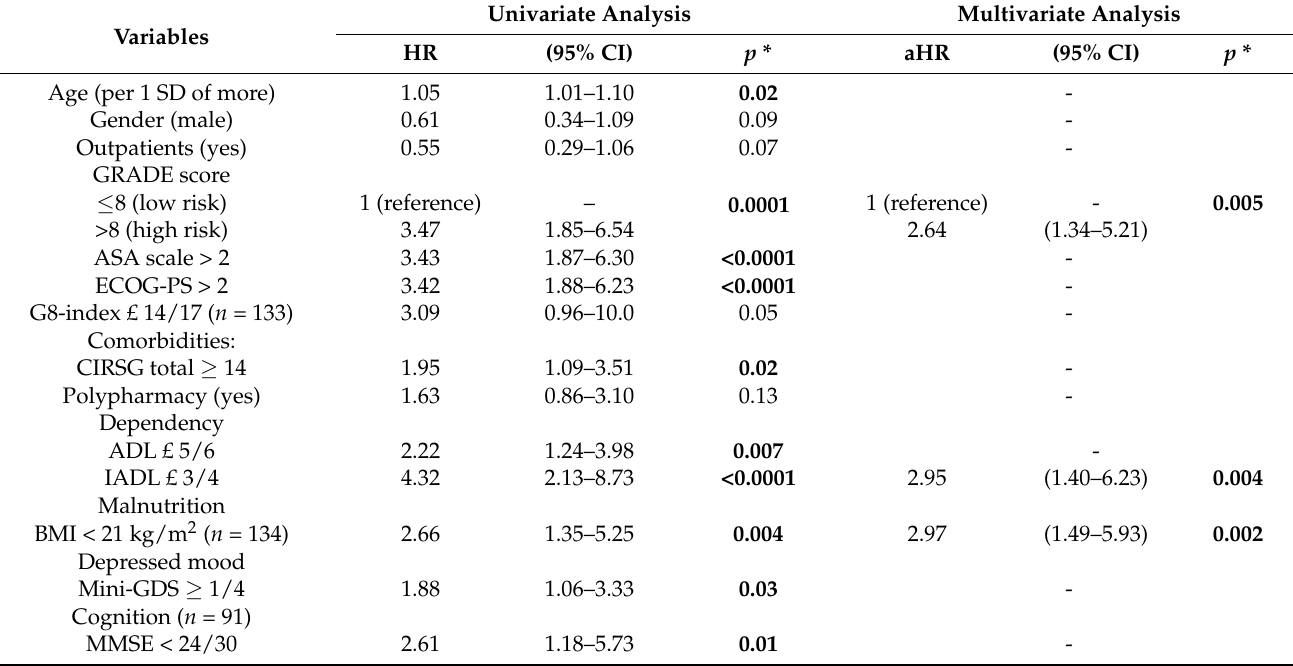
Table 2. Preoperative factors associated with 5-year mortality among 136 older patients with major cancer surgery.